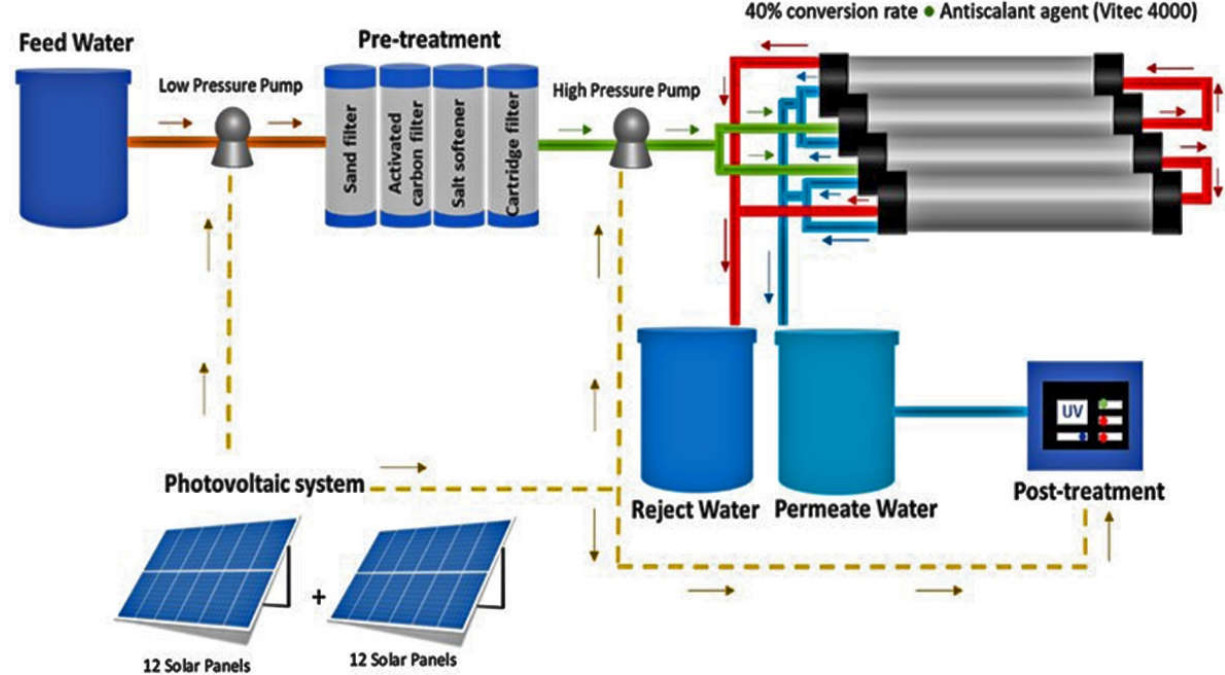
Figure 1. Diagram schematic of RO desalination plant.